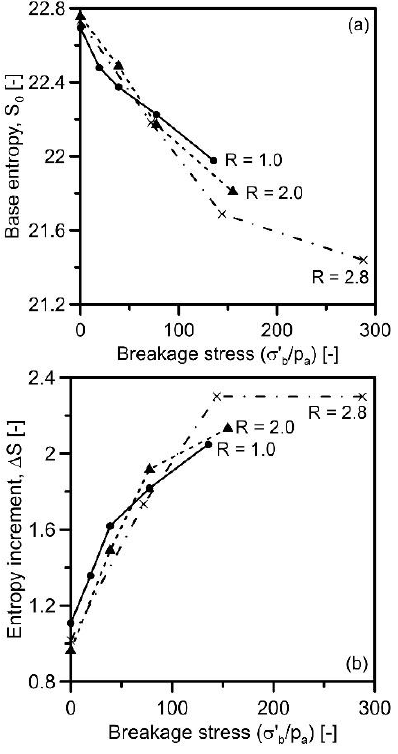
Fig. 3. Evolution of a) base entropy and b) entropy increment with breakage stress (  ’ b ) - data for crushed granite by